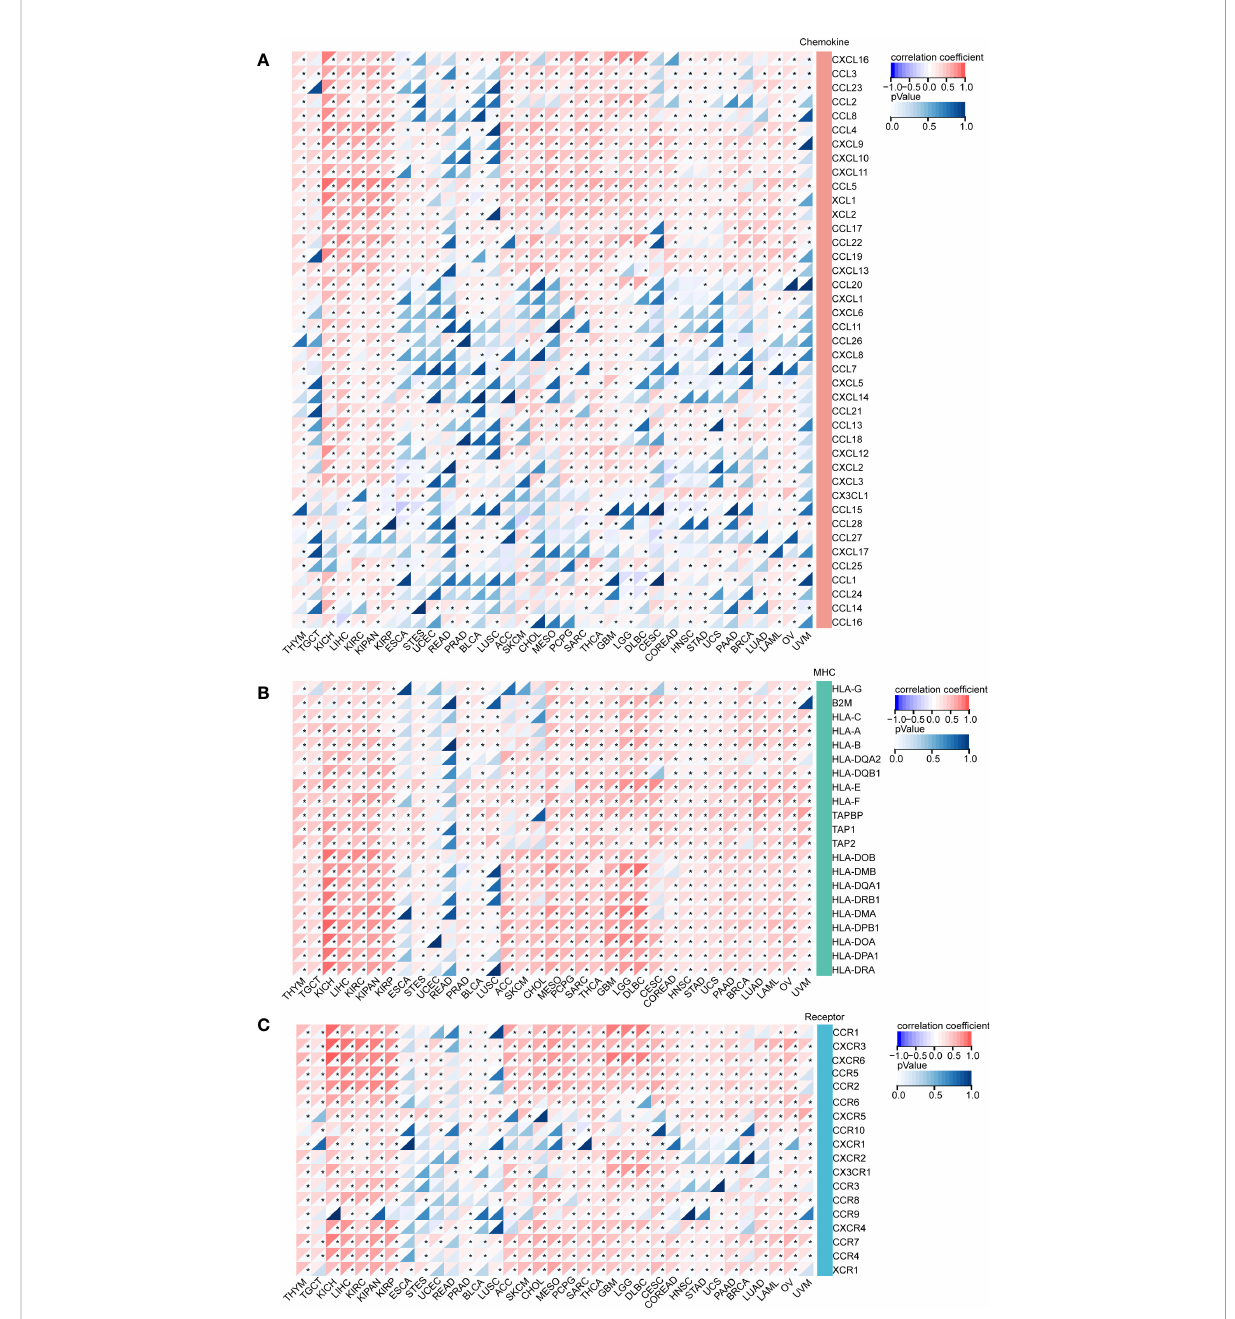
FIGURE 7 The correlation between DEF6 expression and immune related genes. (A) The heat map demonstrates the correlation of DEF6 expression with (A) chemokines, (B) MHC, and (C) receptor genes in a variety of cancers. MHC, major histocompatibility complex. *Correlation p < 0.05. p -values are adjusted using the BH